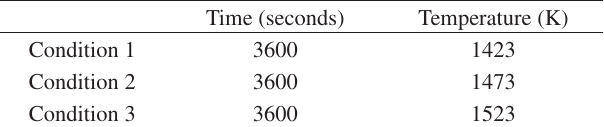
Table 2. Description of the sintering cycle configuration sample on the cathode (CAC).